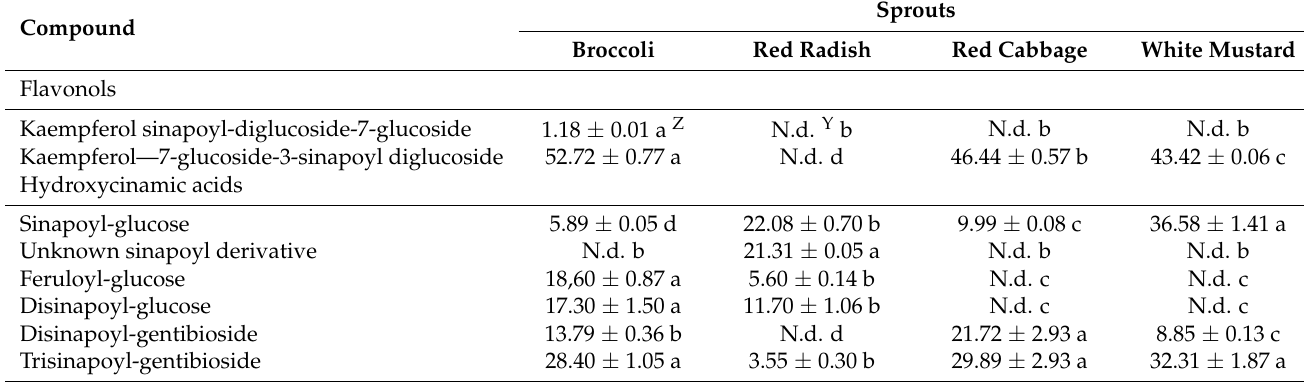
Table 3. Quantitative profile (mg/100 g fw) of phenolic compounds of broccoli ( Brassica olreacea var. italica L. cv. ‘Cal- abrese’), red radish ( Raphanus sativus var. Sativus L. cv. ‘Rambo’), white mustard ( Sinapis alba L.), and red cabbage ( Brassica rapa L. var. capitata